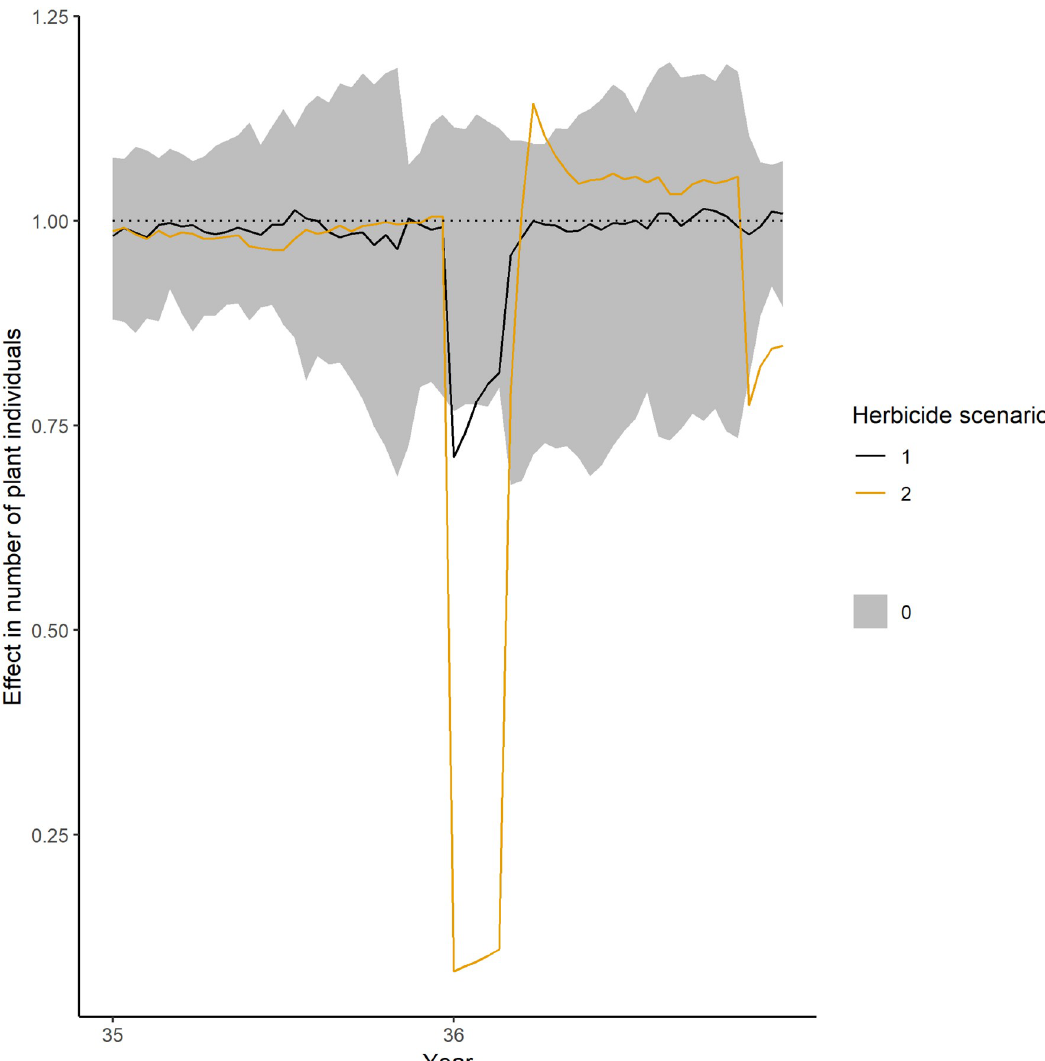
Fig 4. Short-term impacts on number of plant individuals during the first year of simulated herbicide application. Values below 1 represent a negative impact, values equal to 1 no impact and values above 1 a positive impact. The theoretical herbicide had an impact on biomass and mortality. PFTs had random dose response-curves. Grey ribbon shows the fluctuation within control simulations, the black line shows the mean for an application rate of 1.1 g a.i./ha (herbicide scenario 1) and the orange line the mean for an application rate of 3.3 g a.i./ha (herbicide scenario